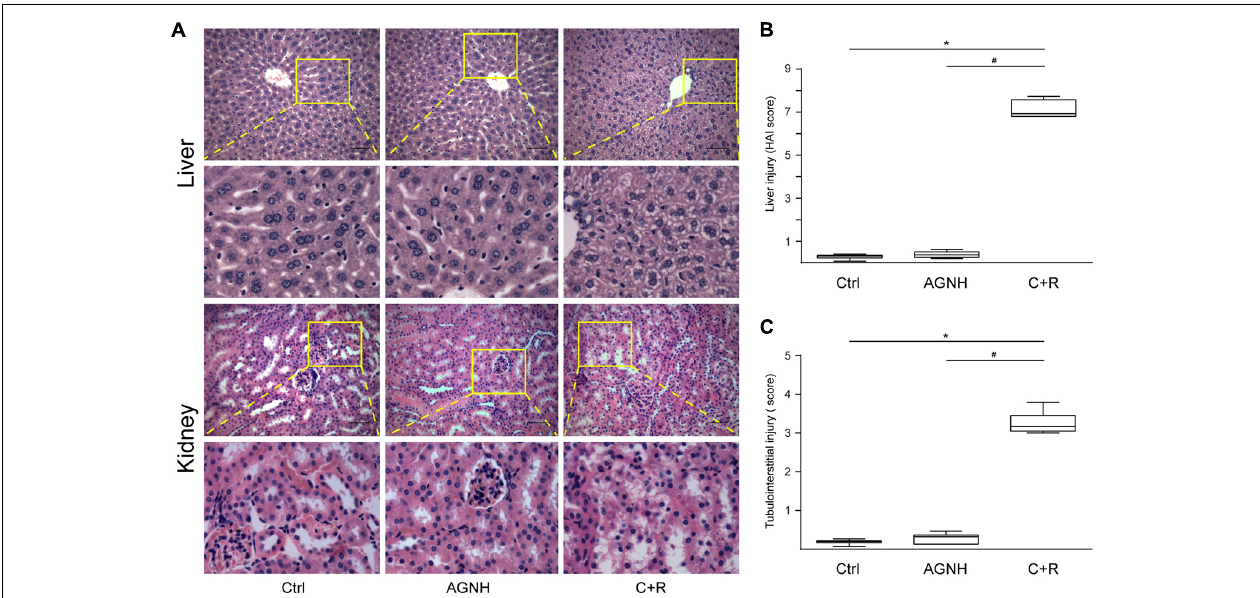
FIGURE 1 | (A) Representative photomicrographs of liver and kidney sections stained with hematoxylin-eosin in mice from three different groups: Ctrl, saline operated; AGNH, An-Gong-Niu-Huang Wan 2.5 g/kg/d treatment for consecutive 28 days; C+R, cinnabar and reaglar 0.14 + 0.14 g/kg/d combinational treatment for consecutive 28 days. Enlarged images of the boxed regions were shown below the boxed panels. Scale bar: 50 µ m. Histopathology was assessed using the (B) histology activity index (HA1) and (C) renal tubular injury (TI) scoring system in liver and kidney specimens, respectively. Horizontal bars, medians. ∗ P < 0.05, saline control versus cinnabar and reaglar co-administration; # P < 0.05, An-Gong-Niu-Huang Wan versus cinnabar and reaglar co-administration.